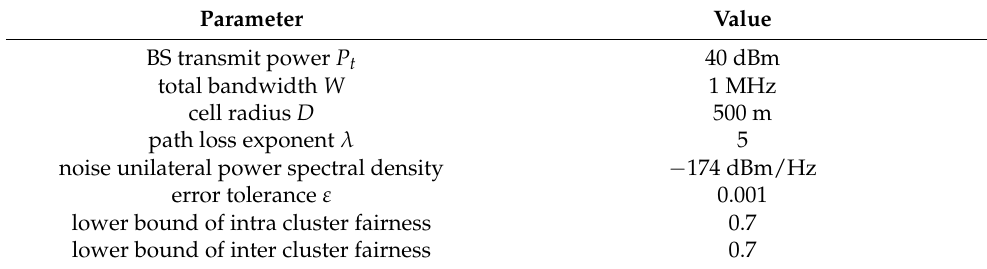
Table 2. Simulation parameters.